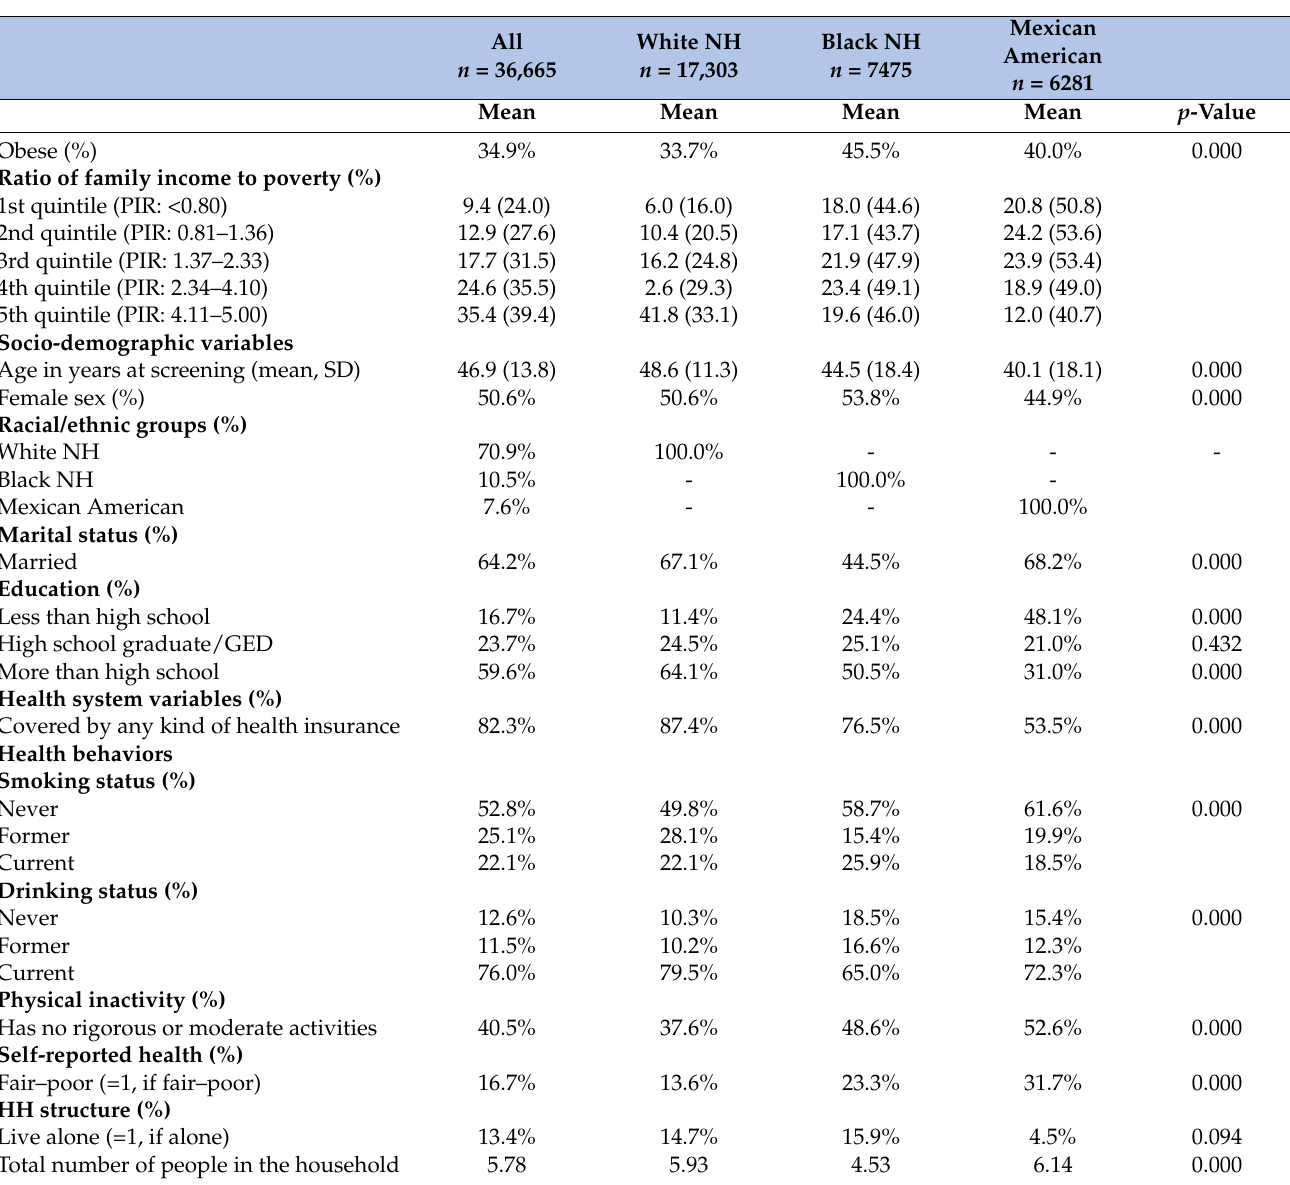
Table 1. Distribution of selected characteristics of U.S. adults over 20 years of age between 1999–2016, National Health and Nutrition Examination Survey ( n =